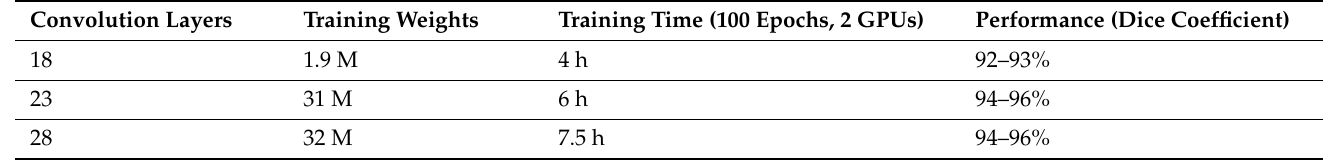
Table 3. Model performance with convolutional layers.